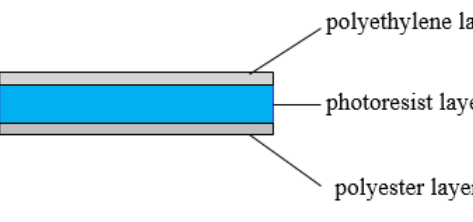
Figure 4. Sketch of photo-sensory membrane.